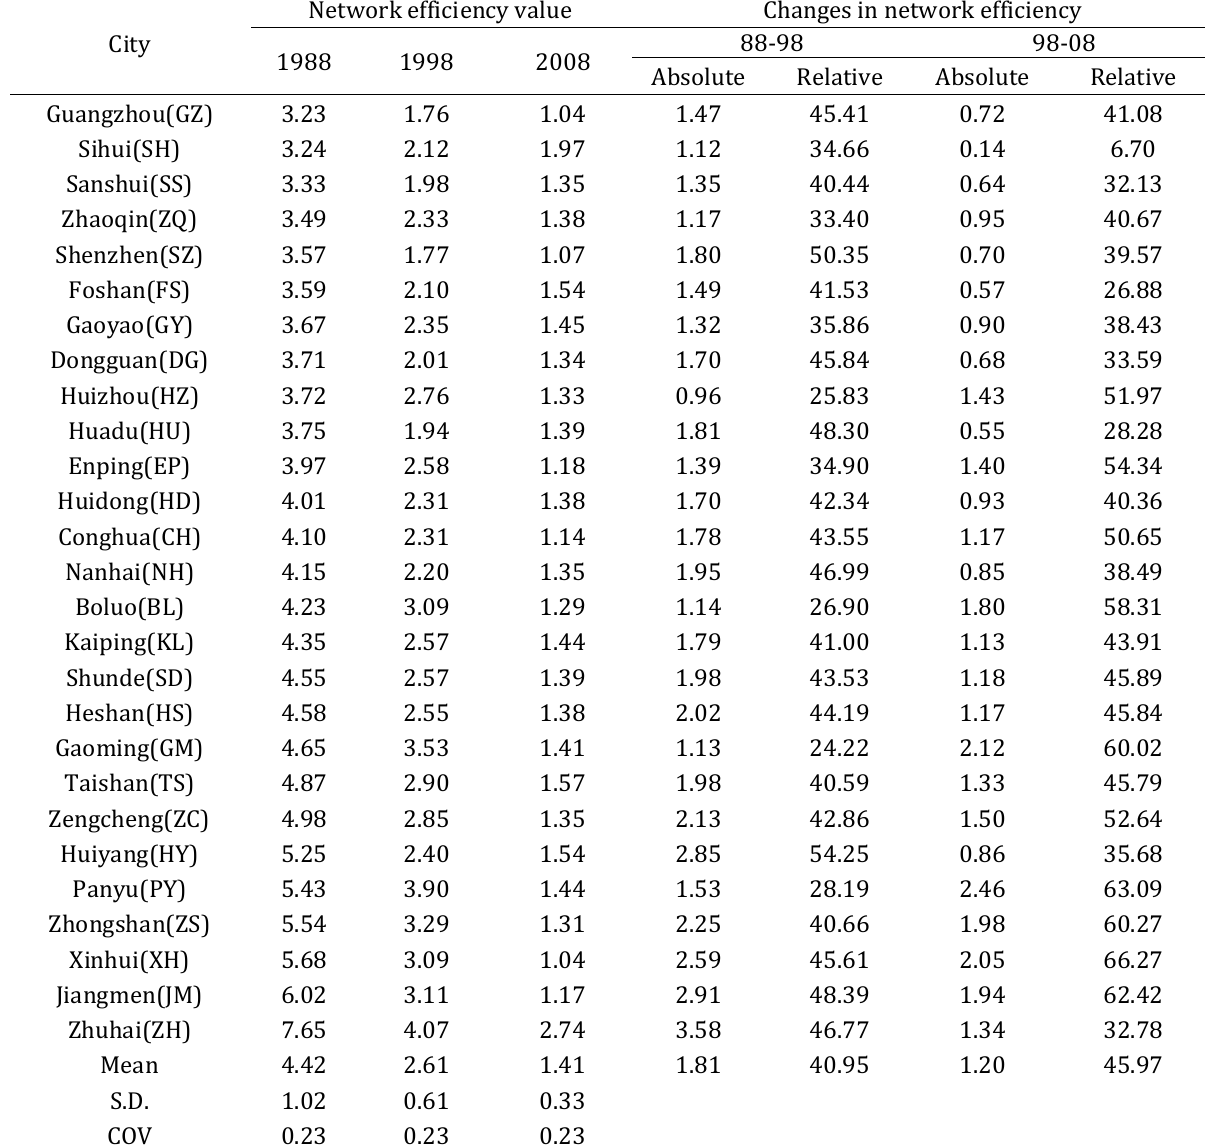
Table 2: The network efficiency in the PRD, 1988-2008 Network efficiency value Changes in network efficiency City 1988 1998 2008